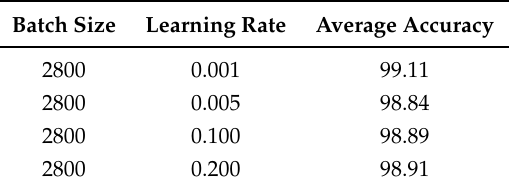
Table 3. Learning rate and average accuracy for a batch size of